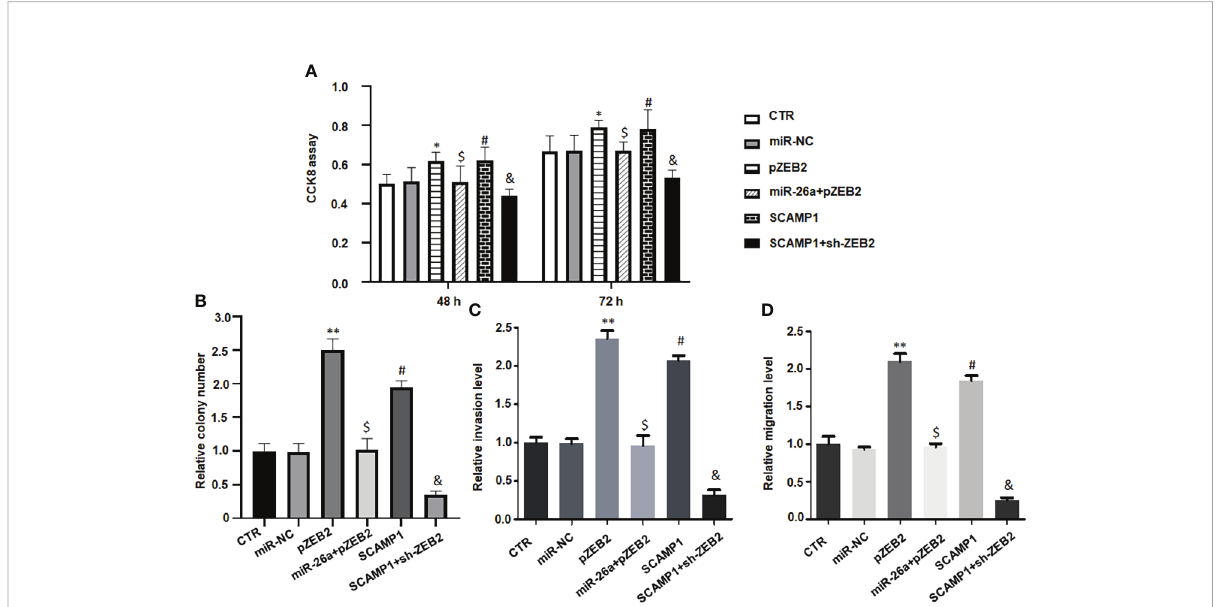
FIGURE 7 LncRNA SCAMP1 increases cell malignant progression via miR-26a/ZEB2 axis. (A) : CCK8 assays data showed that upregulation of ZEB2 abrogated miR-26a-5p-induced inhibition of cell viability in MG63 cells. SCAMP1 overexpression elevated cell viability, which was blocked by downregulation of ZEB2 in MG63 cells. (B) : Colony formation data showed that ZEB2 cDNA transfection increased colony formation of MG63 cells, which was abrogated by miR-26a mimics transfection. SCAMP1 upregulation elevated colony formation of MG63 cells, which was blocked by sh-ZEB2 transfection. (C) : Transwell invasion assay data showed that upregulation of ZEB2 abrogated miR-26a-5p-induced suppression of cell invasion in MG63 cells. SCAMP1 overexpression elevated cell invasion, which was reduced by downregulation of ZEB2 in MG63 cells. Right panel: quantitative data is shown for invasion assay of left panel. (D) : Wound healing assays showed that ZEB2 cDNA transfection increased migrative ability of MG63 cells, which was abrogated by miR-26a mimics transfection. LncRNA SCAMP1 upregulation elevated migrative ability of MG63 cells, which was blocked by sh-ZEB2 transfection. **p<0.01 vs. control group; $ p<0.01 vs. pZEB2 group; # p<0.01 vs. control group; & p<0.01 vs. SCAMP1 group. ; *p < 0.05 vs control